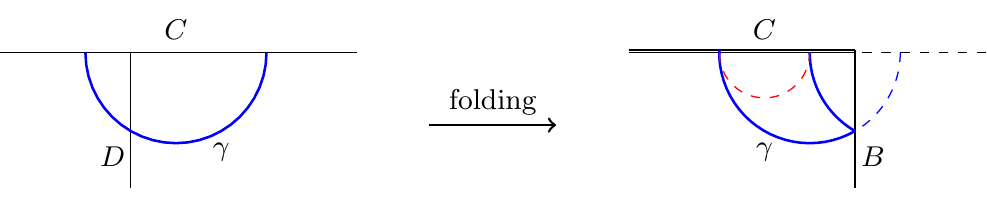
Figure 2 . Folding of a geodesic across the defect in a dCFT to a long geodesic in a bCFT. C denotes the conformal boundary of the asymptotically-AdS geometry while D / B labels the extension of the defect/boundary into the